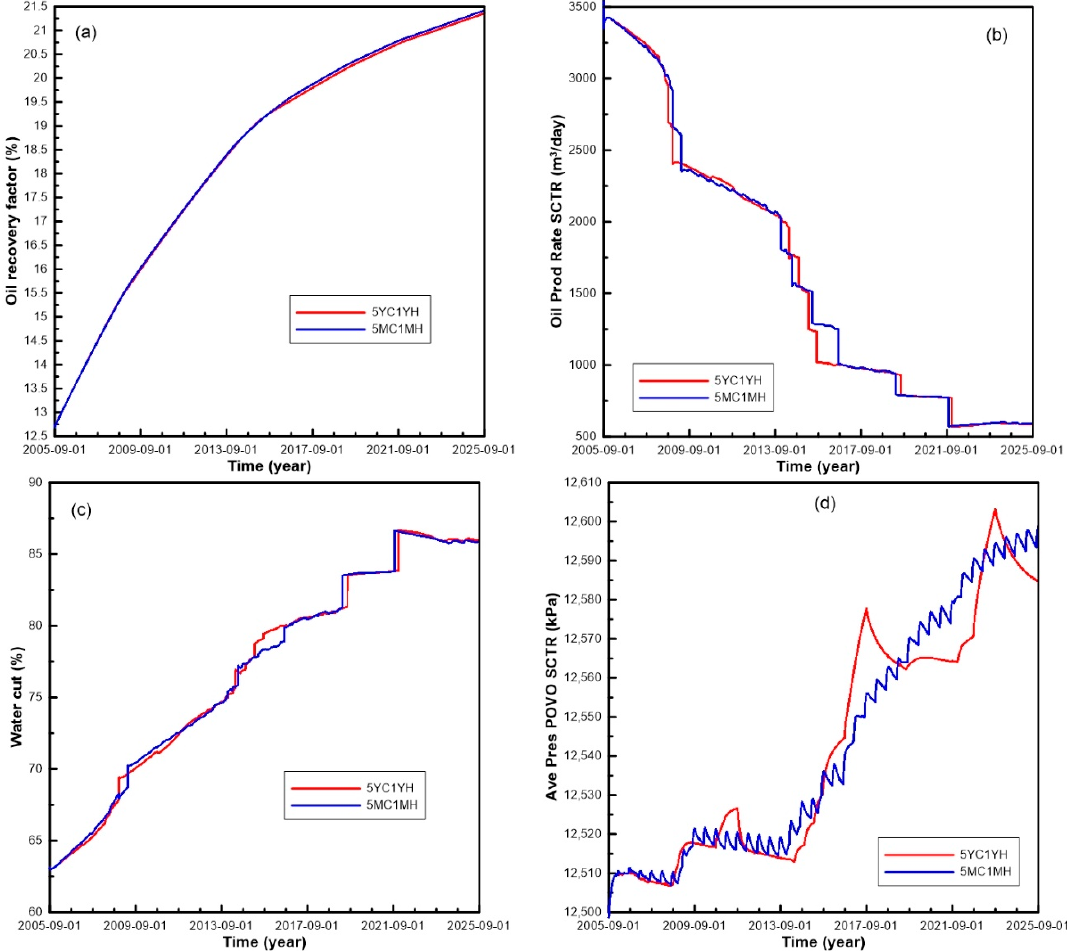
Figure 13. Simulated curves of oil recovery factor ( a ), oil production rate ( b ), water cut ( c ) and average reservoir pressure ( d ) of during the CO 2 flooding with a WAG ratio of 5:1.